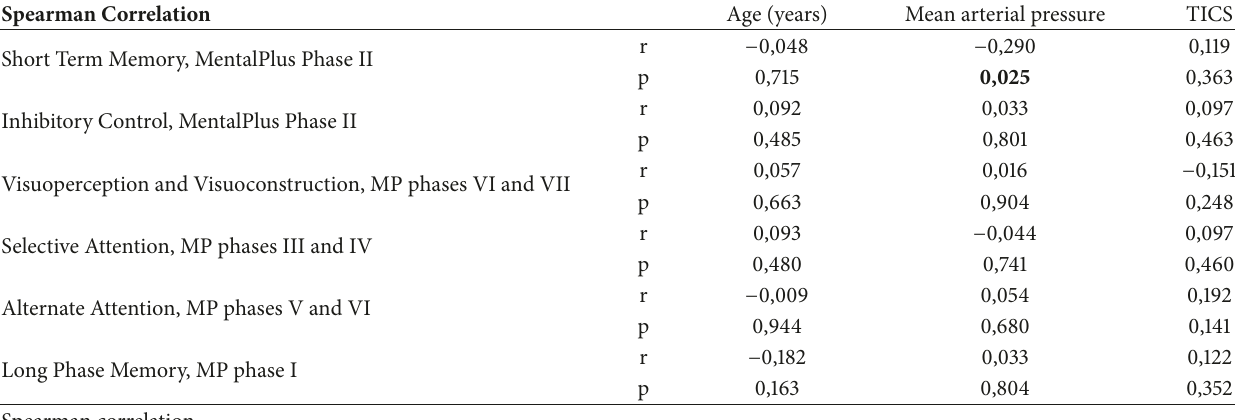
Table 3: Spearman correlation with MentalPlus (cid:2) phases, with patients age, mean arterial pressure, and TICS. Spearman